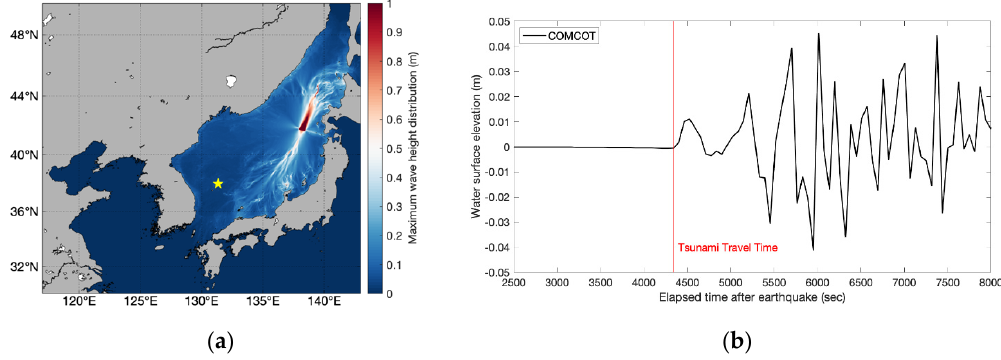
Figure 8. Tsunami arrival time for scenario 01 in Table A1. ( a ) Randomly chosen point (yellow star, (131.3640° E, 37.9726° N)) displays the maximum tsunami wave height distribution. ( b ) Water surface elevation at the same random point. The red line indicates the Tsunami Travel Time of a randomly chosen location.